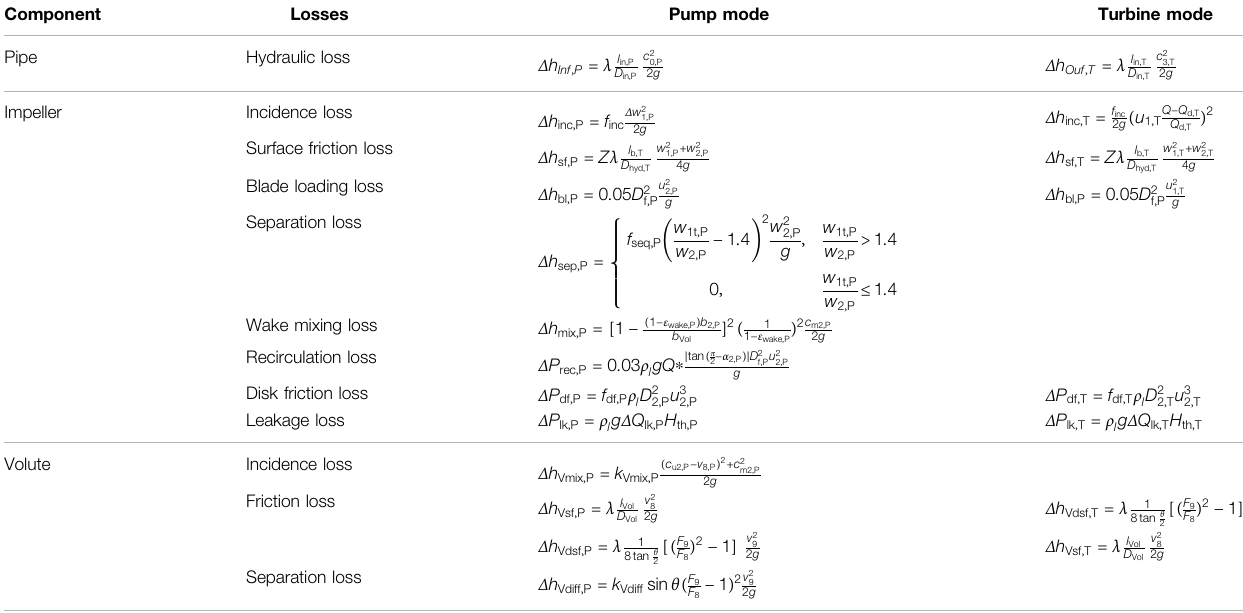
TABLE 6 | Losses modeling in Liu ’ s method (Liu et al., 2019). Component Losses Pump mode Turbine